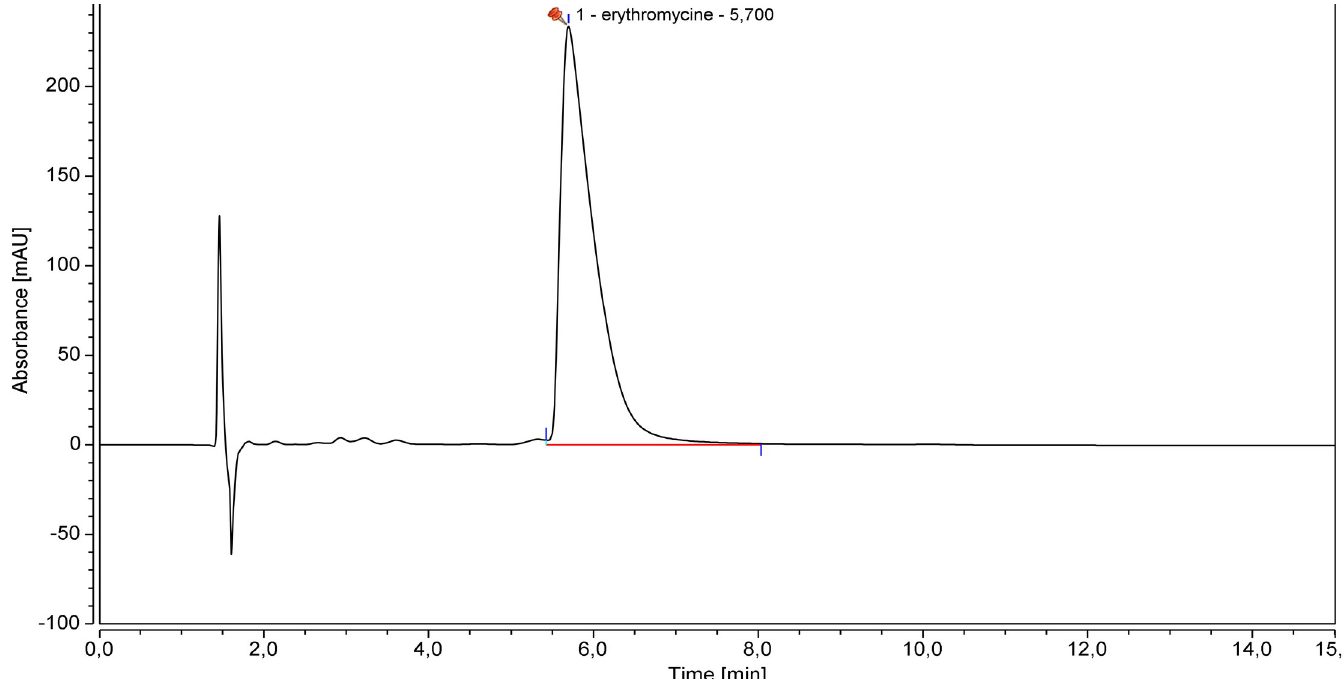
Fig 1. Representative erythromycin